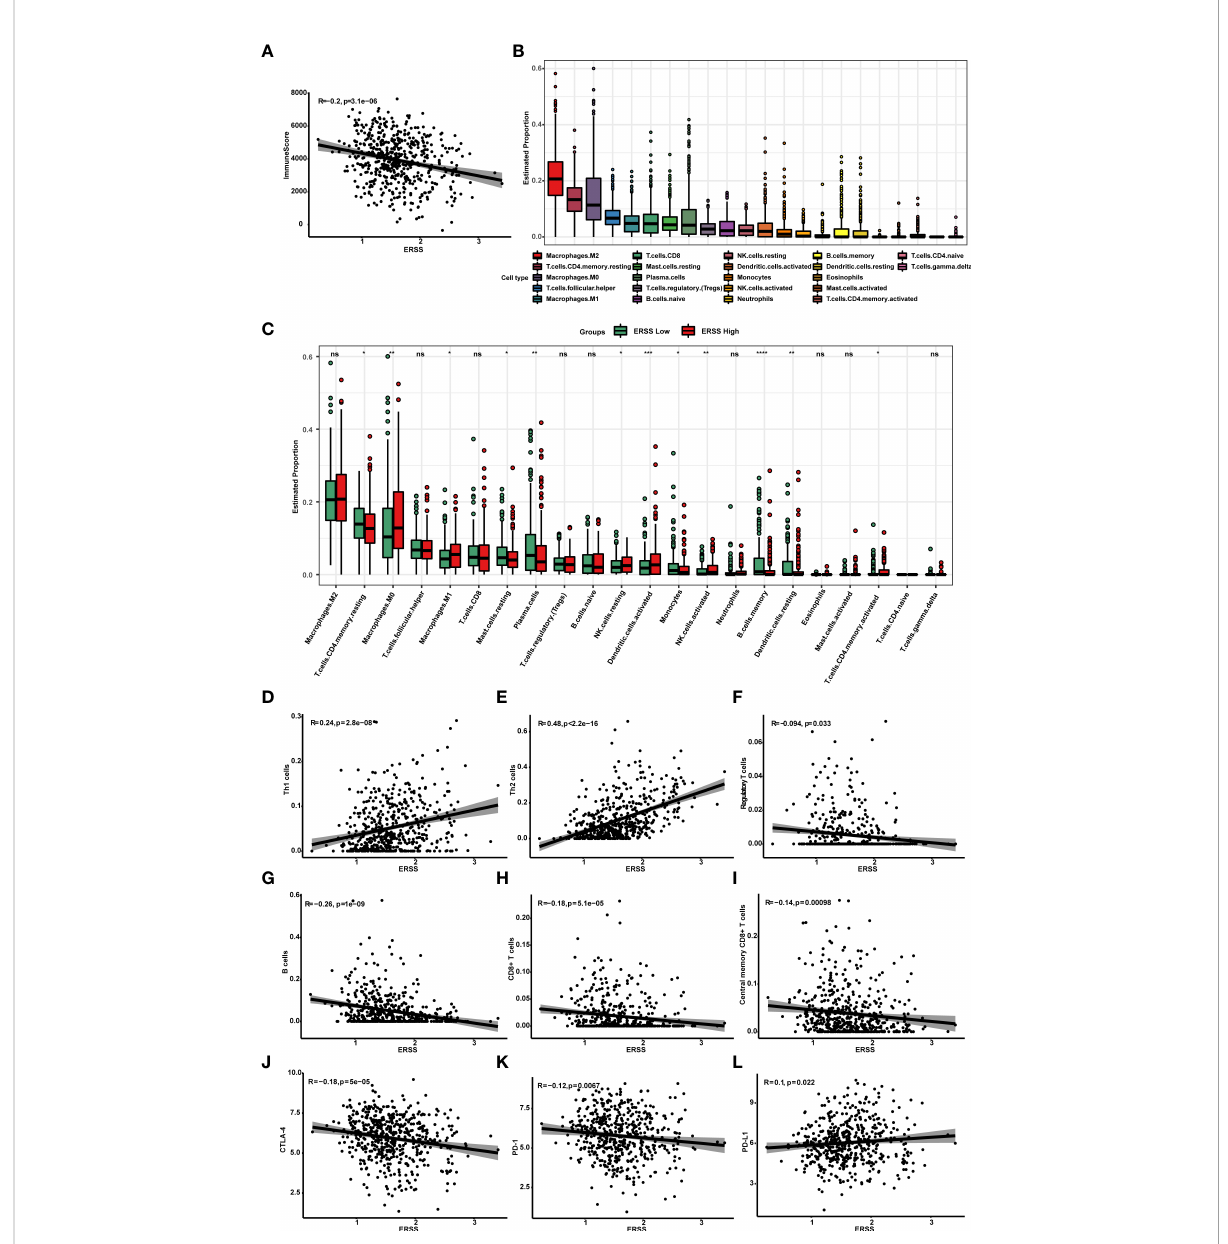
FIGURE 7 High ERSS correlated with a suppressive tumor immune microenvironment. (A) ESTIMATE algorithms showed that ERSS negatively correlated with immune score ( p = 3.1e − 06, R = − 0.2), suggesting that higher ERSS was accomplished with less immune cell in fi ltration. (B) Twenty-two types of immune cells were evaluated by CIBERSORT algorithms. M2 macrophages accounted for the highest proportion of all immune cells, followed by resting CD4+ memory T cells. (C) The level of in fi ltrating immune cells was well compared by a multi-group box diagram between high and low ERSS groups (median value of ERSS was used to distinguish high and low groups). Compared with the low ERSS groups, the high ERSS group had signi fi cantly higher in fi ltration of M0 macrophages, M1 macrophages, resting NK cells, activated dendritic cells, and activated CD4+ memory T cells and lower in fi ltration of resting CD4+ memory T cells, resting mast cells, plasma cells, monocytes, memory B cells, and resting dendritic cells. (D – F) We performed xCell algorithms to further clarify the changes in different subtypes of CD4+T cells. Th1 cells ( p = 2.8e − 08, R = 0.24) and Th2 cells ( p < 2.2e-16, R = 0.48) were positively with ERSS. Regulatory T cells were negatively associated with ERSS ( p = 0.033, R = − 0.094). (G – I) Meanwhile, xCell algorithms showed that ERSS negatively correlated with in fi ltration of B cells ( p = 1e − 09, R = − 0.26), CD8+ T cells ( p = 5.1e − 05, R = − 0.18), and central memory CD8+ T cells ( p = 0.00098, R = − 0.14). (J – L) Higher ERSS was signi fi cantly associated with lower expression of CTLA-4 ( p = 5e − 05, R = − 0.18) and PD-1 ( p = 0.0067, R = − 0.12) and higher expression of PD-L1 ( p = 0.022, R = 0.1). ERSS, endoplasmic reticulum stress score; TCGA, The Cancer Genome Atlas; LUAD, lung adenocarcinoma. * p <0.05, ** p <0.01, *** p <0.0001, and ns means p